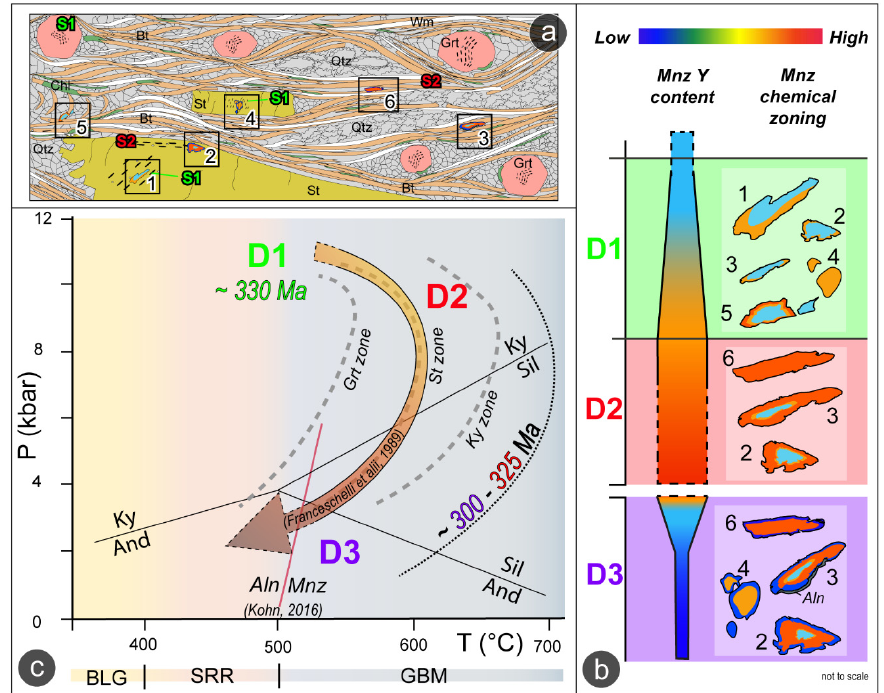
Figure 11. ( a ) Schematic drawing of a thin section where the six possible monazite microstructural positions found in the three analyzed samples were indicated (1–6); ( b ) interpretation of monazite growth-stages along the prograde and retrograde segments of the P–T path. Monazite Y content and chemical zoning are qualitatively indicated; ( c ) P–T–D–t path (based on Franceschelli et al. 1989 [51]) of the three studied samples from staurolite- and garnet-bearing micaschist. BLG = bulging; SRR = subgrain rotation recrystallization; GBM = grain boundary migration.